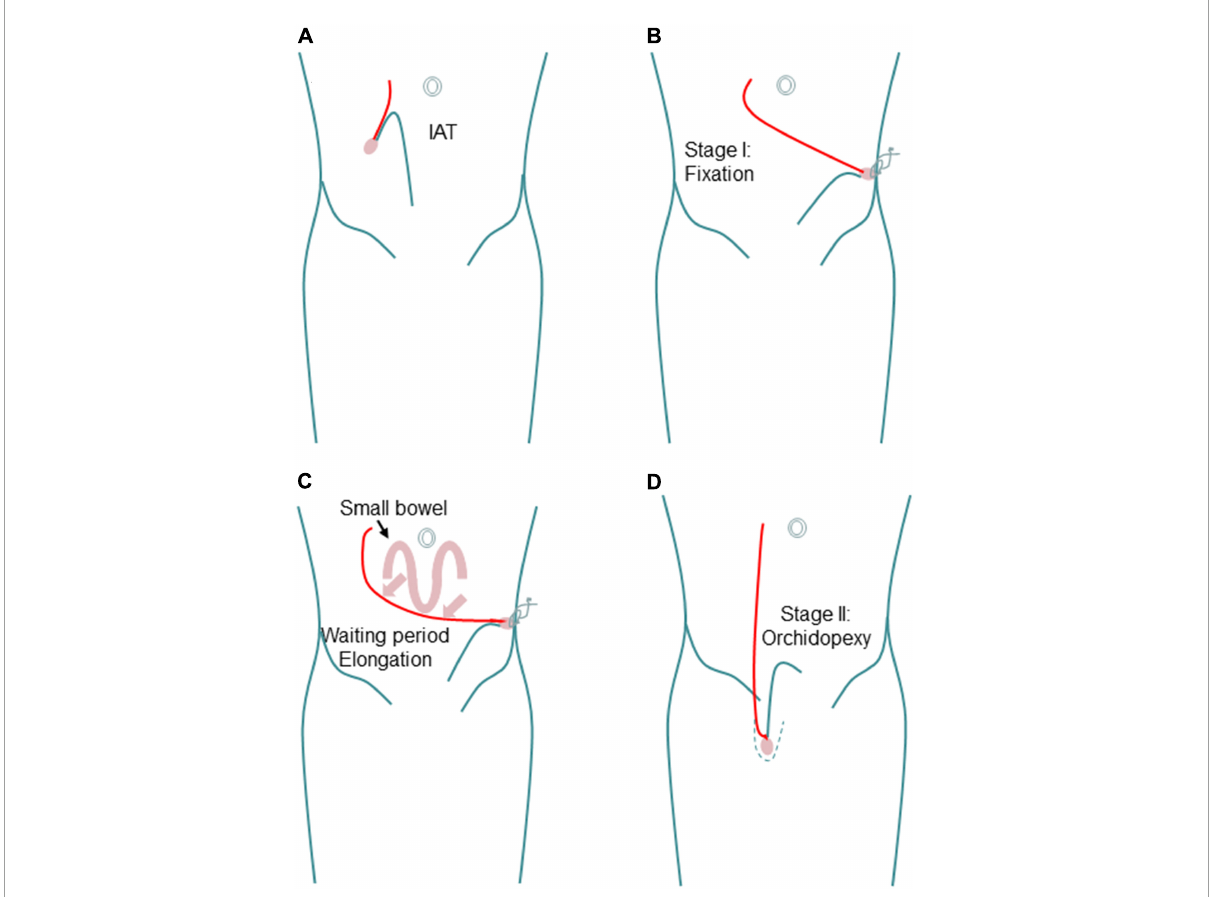
FIGURE1 Schematic diagram showing the steps of Shehata technique. (A) Intra-abdominal testis. (B) Fixation in stage I. (C) Progressive gradual elongation during waiting period. (D) Scrotal position in stage